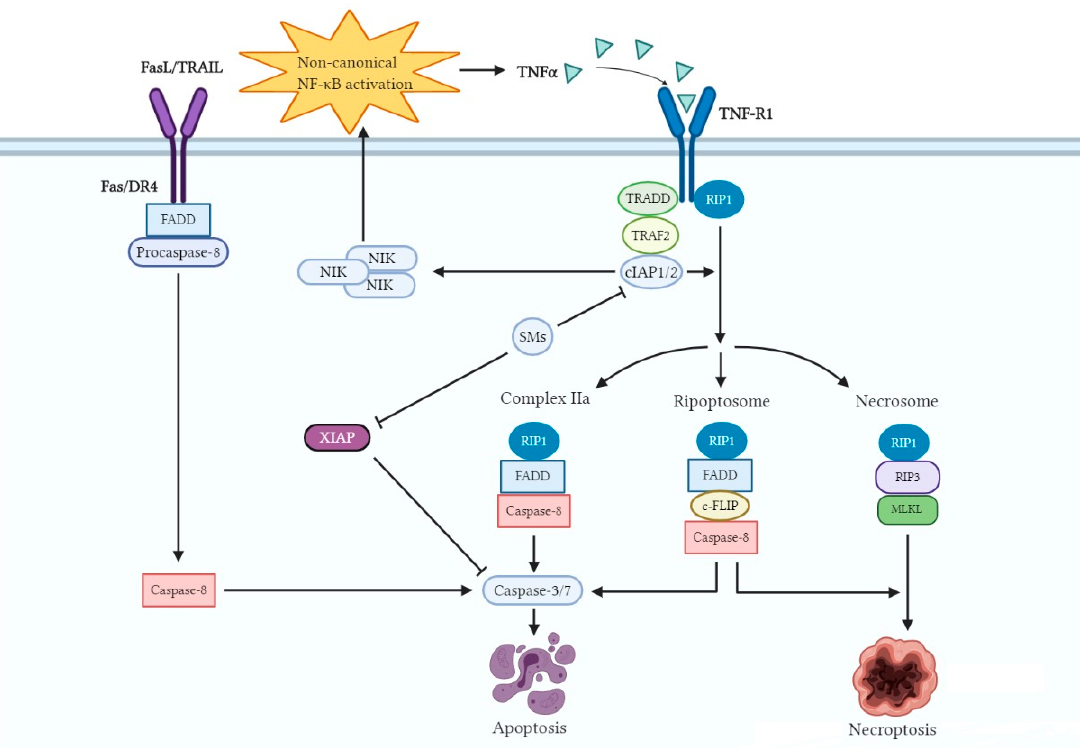
Figure 3. Regulation of cell death pathways by SMs. The binding of SMs to cIAPs, which enhances the E3 ubiquitin ligase activity of cIAPs, resulting in autoubiquitination and proteasomal degradation. These alterations lead to nuclear factor- κ B (NF- κ B)-inducing kinase (NIK) accumulation, non-canonical NF- κ B activation, and tumor necrosis factor alpha (TNF α ) production. The degradation of cIAPs raises three possible formations, i.e., complex IIa, ripoptosome, and necrosome, which induce cancer cell death. Meanwhile, SMs can directly bind XIAP, thereby activating caspases and inducing apoptosis.